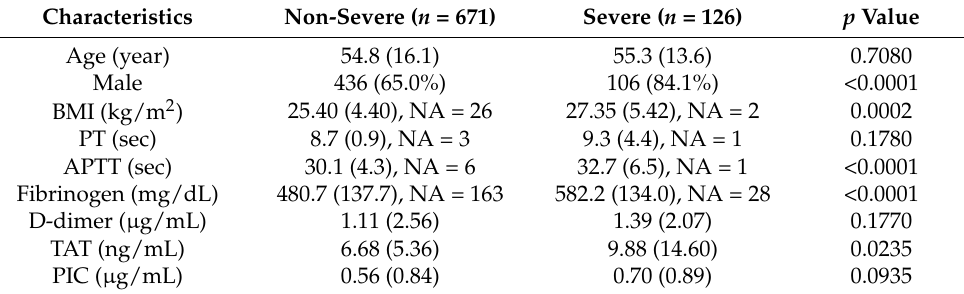
Figure 1. Study population flowchart. The final study cohort comprised 797 patients. Analysis 1 presents clinical characteristics of 797 patients (non-severe group, n = 671, and severe group, n = 126). More detailed results are shown in Table 1. Analysis 2 presents clinical characteristics of 589 patients (non-severe group, n = 515, and severe group, n = 74) and factors that affect severe respiratory failure in the normal D-dimer group. Analysis 3 shows clinical characteristics of 208 patients (non- severe group, n = 156, and severe group, n = 52) and factors that affect severe respiratory failure in the elevated D-dimer group. Elevated D-dimer was defined as D-dimer ≥ 1.0 µ g/mL. COVID-19, coronavirus disease 2019. Table 1. Characteristics and outcomes of the patient